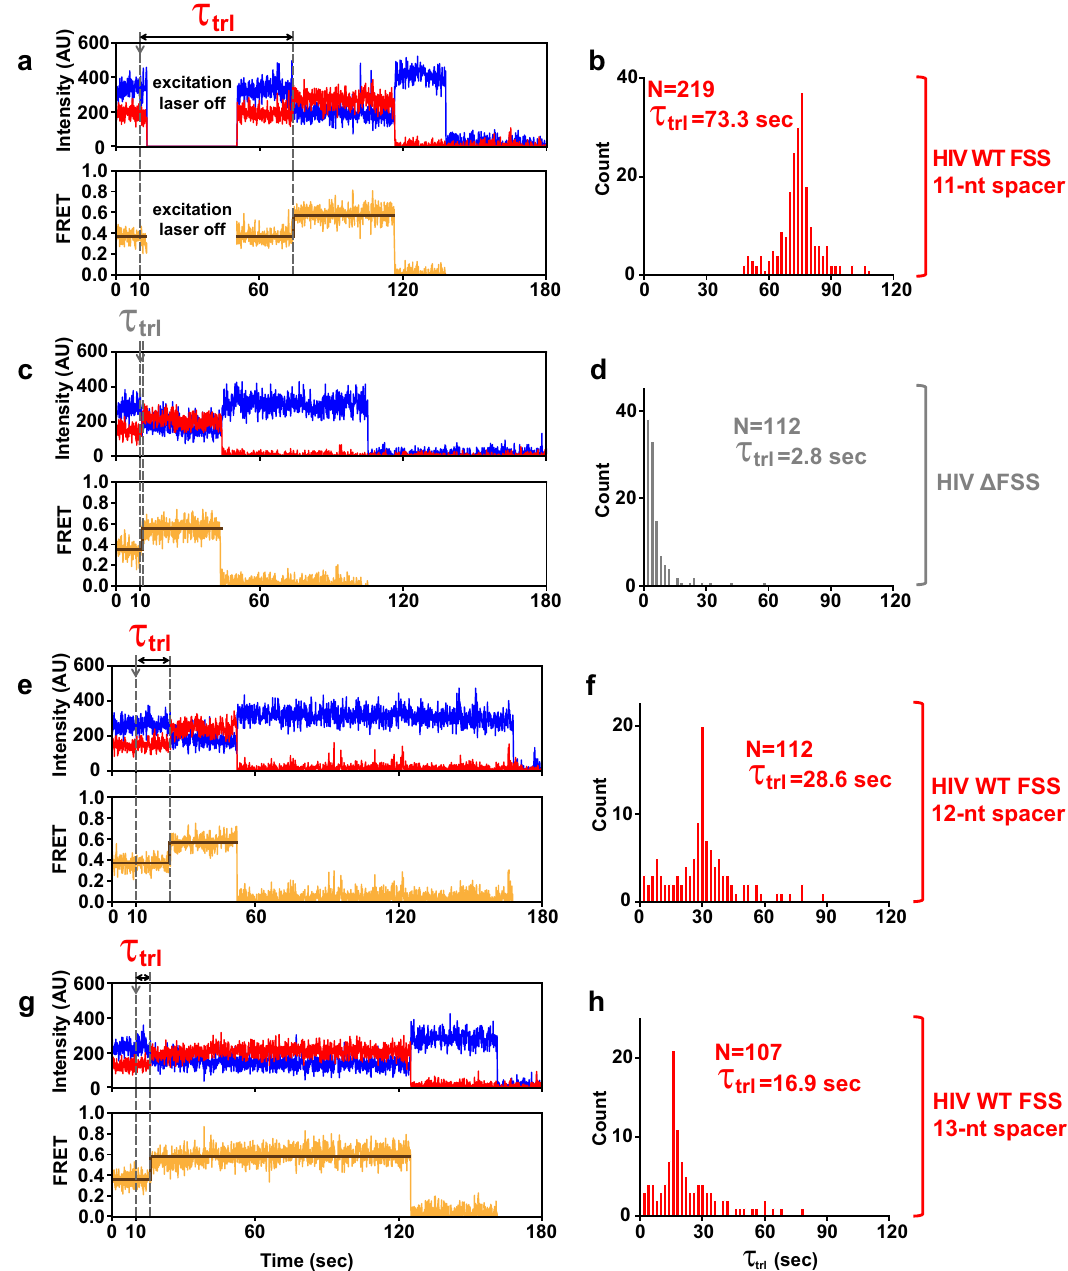
Fig. 5 The FSS-induced inhibition of translocation is in fl uenced by length of the mRNA spacer between P-site codon and FSS. The pre-translocation S6- cy5/L9-cy3-labeled ribosomes were programmed with either HIV WT FSS ( a , b , e , f , g , h ) or HIV Δ FSS ( c , d ) mRNA (Fig. 1). The HIV FSS was positioned either 11 ( a , b ), 12 ( e , f ) or 13 ( g , h ) nucleotides downstream of the P-site codon, respectively. a , c , e , g Representative FRET traces show cy3 donor fl uorescence (blue), cy5 acceptor fl uorescence (red), and FRET ef fi ciency (orange) fi tted by two-state HHM (brown). Arrows show the injection of EF-G (cid:129) GTP. The EF-G- catalyzed translocation corresponds to the transition from R (0.4 FRET) to a stable (i.e. lasting over 4s) NR (0.6 FRET) state of the ribosome. b , d , f , h Histograms (2s binning size) show the distributions and median values of the dwell time between the injection and the translocation, τ trl . N indicates the number of traces assembled into each histogram. To extend lifetime of the acceptor fl uorophore in the experiments with 11 nucleotide spacer mRNA, the excitation laser was turned off after the EF-G injection and switched back on either 40s ( a ) or 60s later. τ trl distribution in ( b ) was combined from data sets acquired with 40s (Supplementary Fig. 4a) and 60s (Supplementary Fig. 4b) laser shut-off times. Source data are provided as a Source Data fi